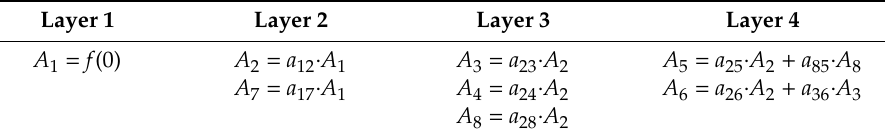
Table 1. Separate layers in the matrix AL with the dependence equations for nodes.